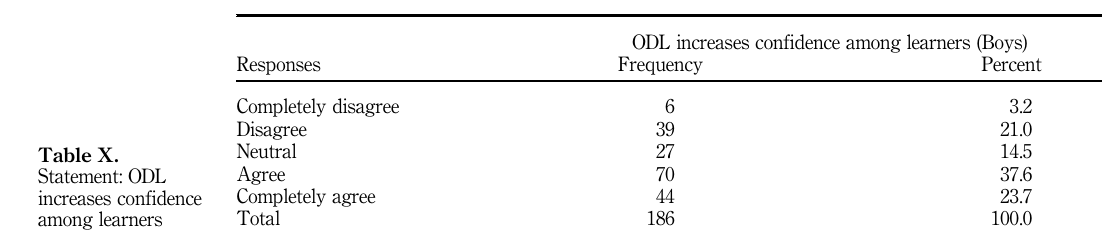
Table IX. Statement: focus of education is on learners (Girls)